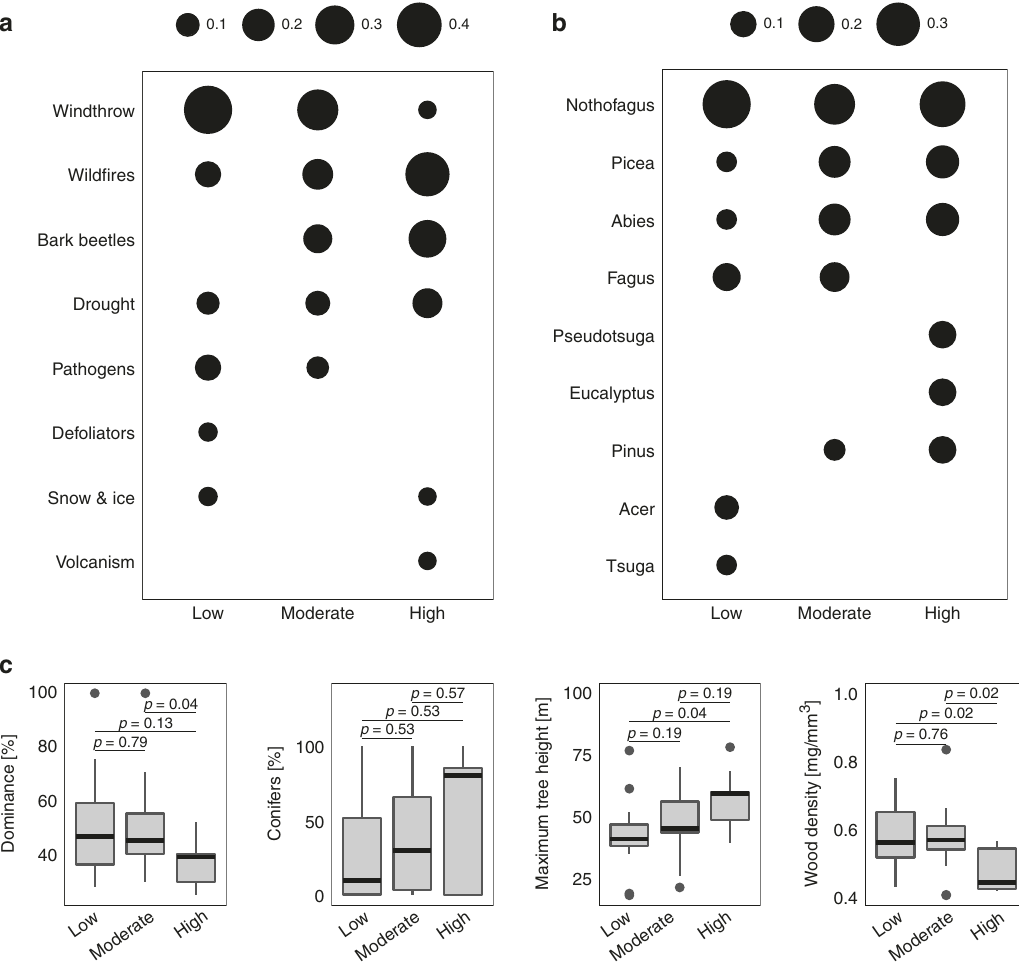
Fig. 2 Distribution of disturbance agents, tree genera, and tree species traits across three global clusters of disturbance activity (cf. Table 1). Bubbles are scaled relative to the occurrence of the two most important a disturbance agents and b tree genera within each cluster. c Dominance [%] indicates the share of the single most prevalent tree species on the overall tree species composition, while conifers [%] indicates the respective share of all conifer species. Maximum tree height and wood density indicate a weighted trait distribution across landscapes in the respective disturbance activity clusters. Boxplots denote the median (center line) and interquartile range (box), with whiskers extending to three times the interquartile range and points indicating values outside this range. Test statistics and p -values are based on approximate Kruskal – Wallis tests with 9999 permutations. For further information